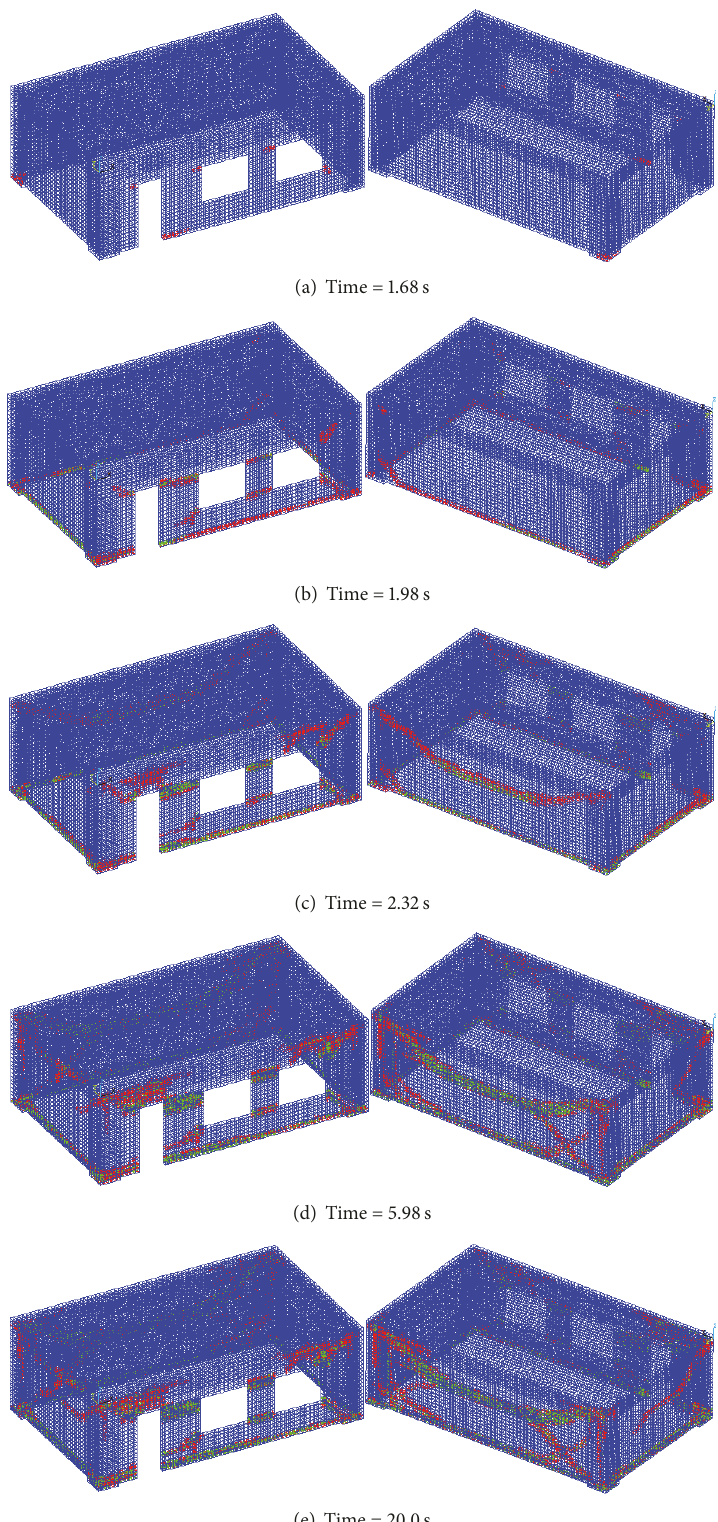
Figure 8: Crack distributions of the original masonry structure at different